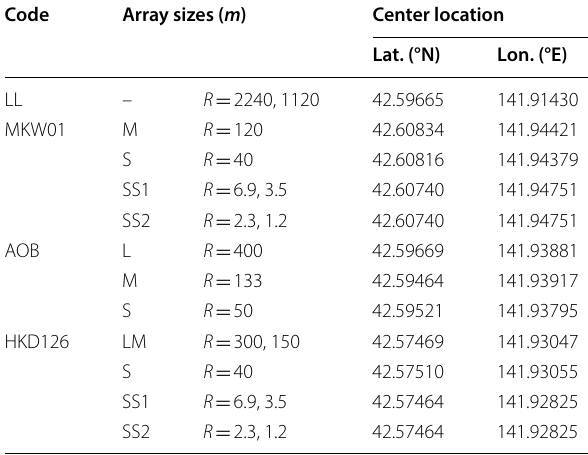
Table 1 Array sizes and locations for the microtremor array